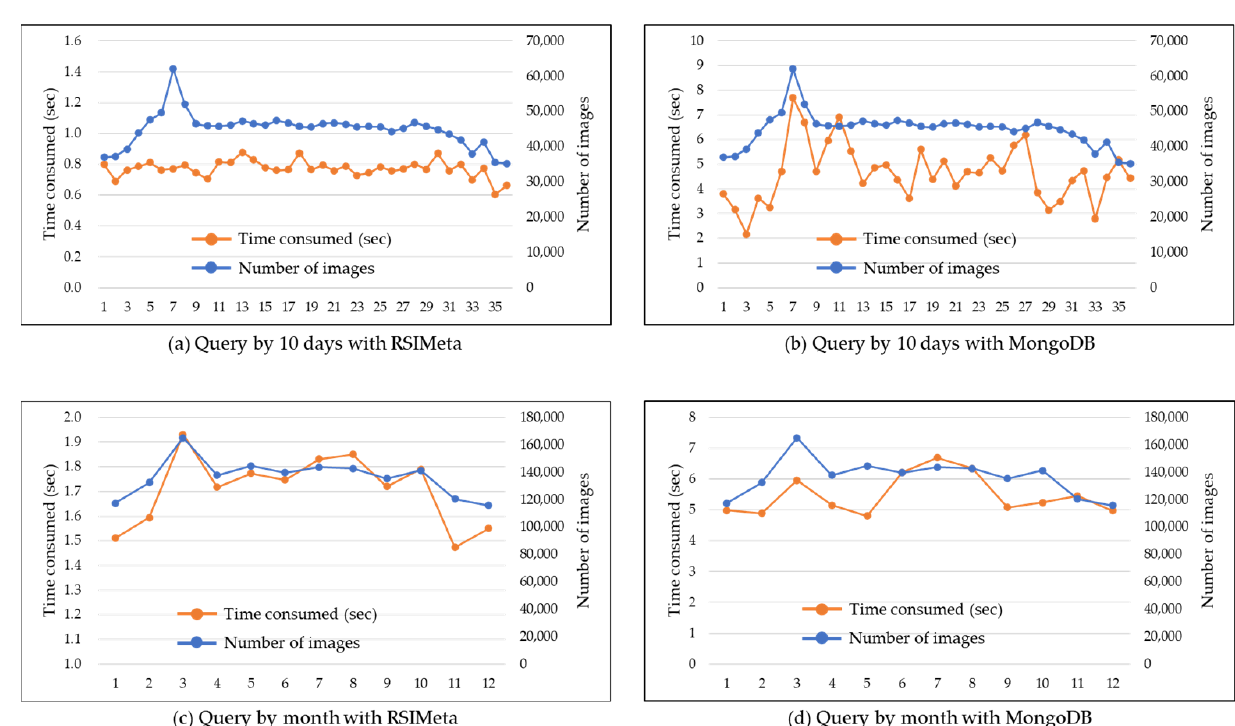
Figure 26. Comparison of temporal query time consumed based on different time windows. Time windows of ( a , b ) are 10 days; Time windows of ( c , d ) is the natural months (from January to Decem- ber)